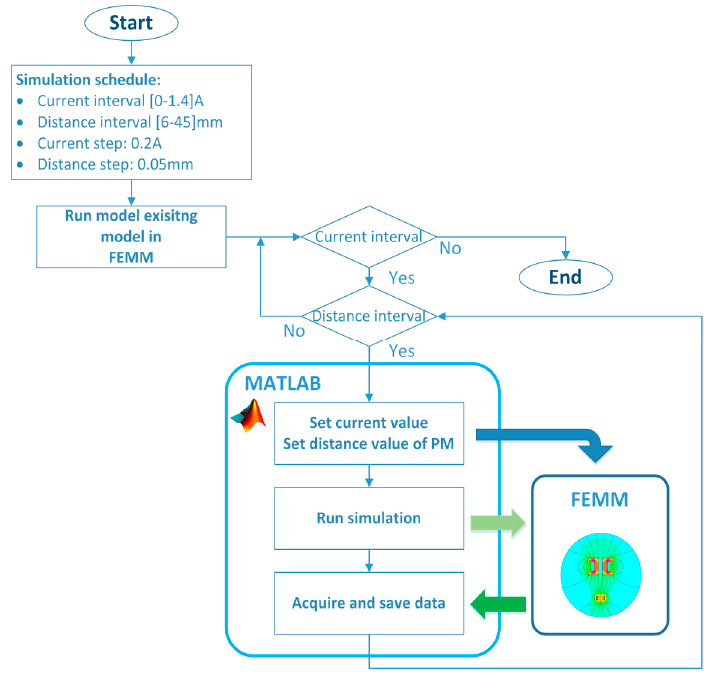
Figure 5. Simulation schedule with coupled Matlab and FEMM software.